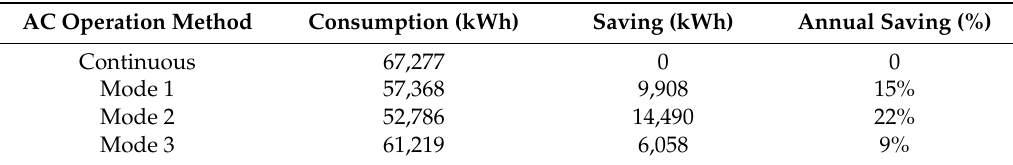
Table 7. Annual energy consumption under the continuous and different modes of AC operation for the Villa.